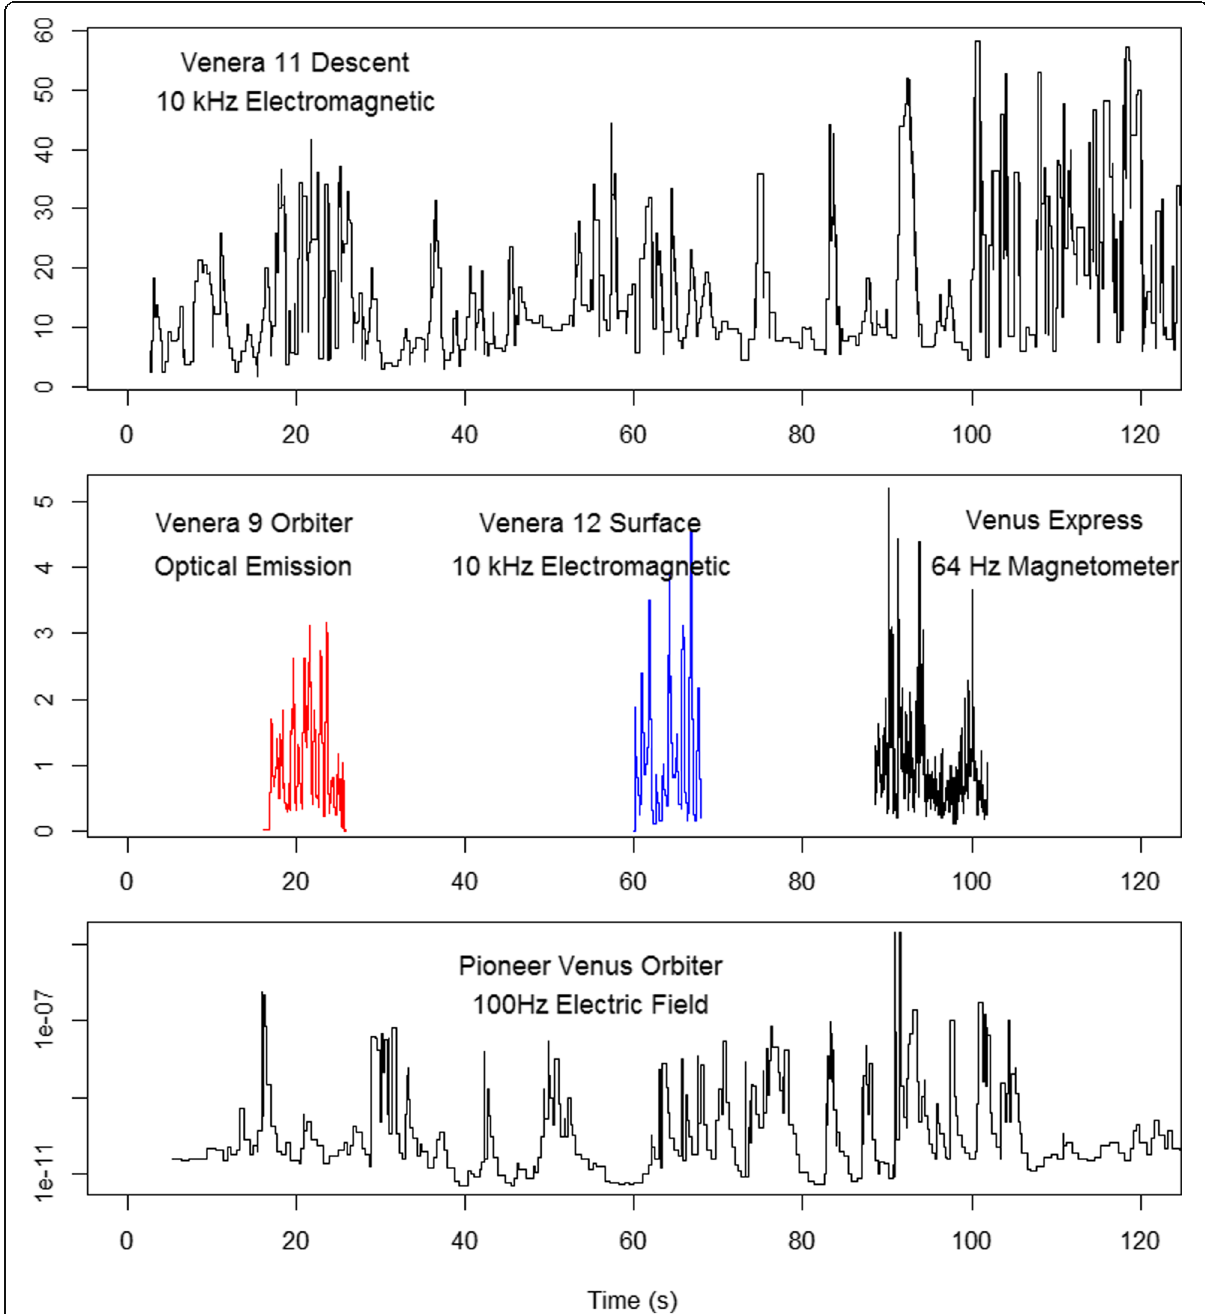
Fig. 10 Several different Venus lightning detections plotted with arbitrary vertical scales, but on the same abscissa, showing the characteristic variability on second and sub-second timescales. It is evident too that the rate of events (bursts/pulses/flashes/strokes) is strongly dependent on the time resolution